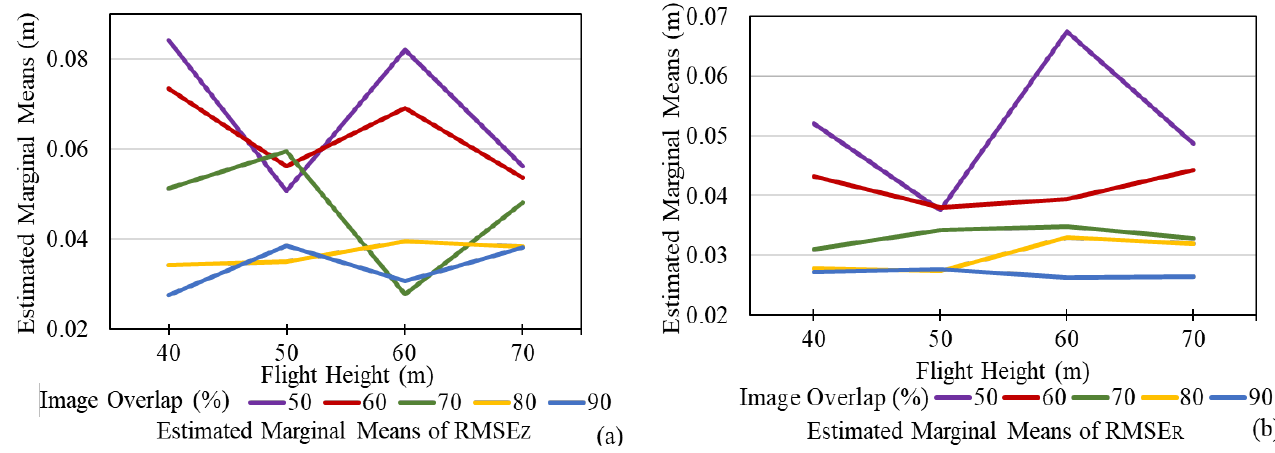
Figure 11. Interaction between Focal Length and Image Overlap; ( a ) RMSE Z ; ( b ) RMSE R .